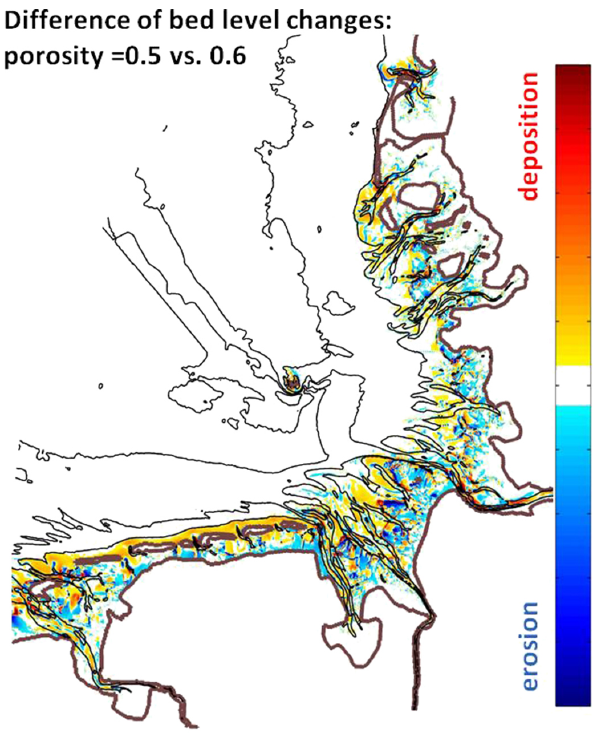
Fig. 2. Differences in bed level changes after 1yr MD simulation with DELFT3D (2-D mode) due to a change of the porosity param- eter from 0.5 to